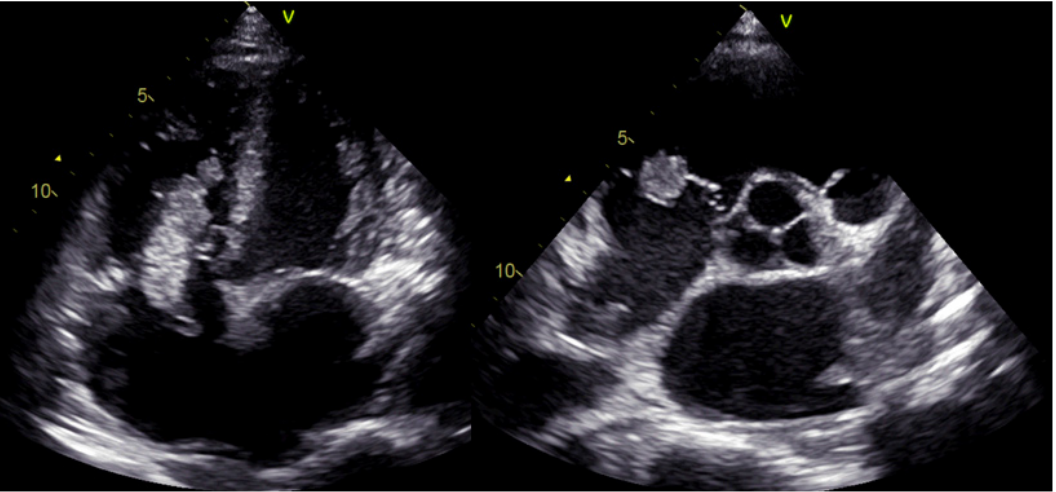
Figure 6. Transthoracic echocardiogram (TTE) showing protruded thrombus in the right atrium passes through the tricuspid